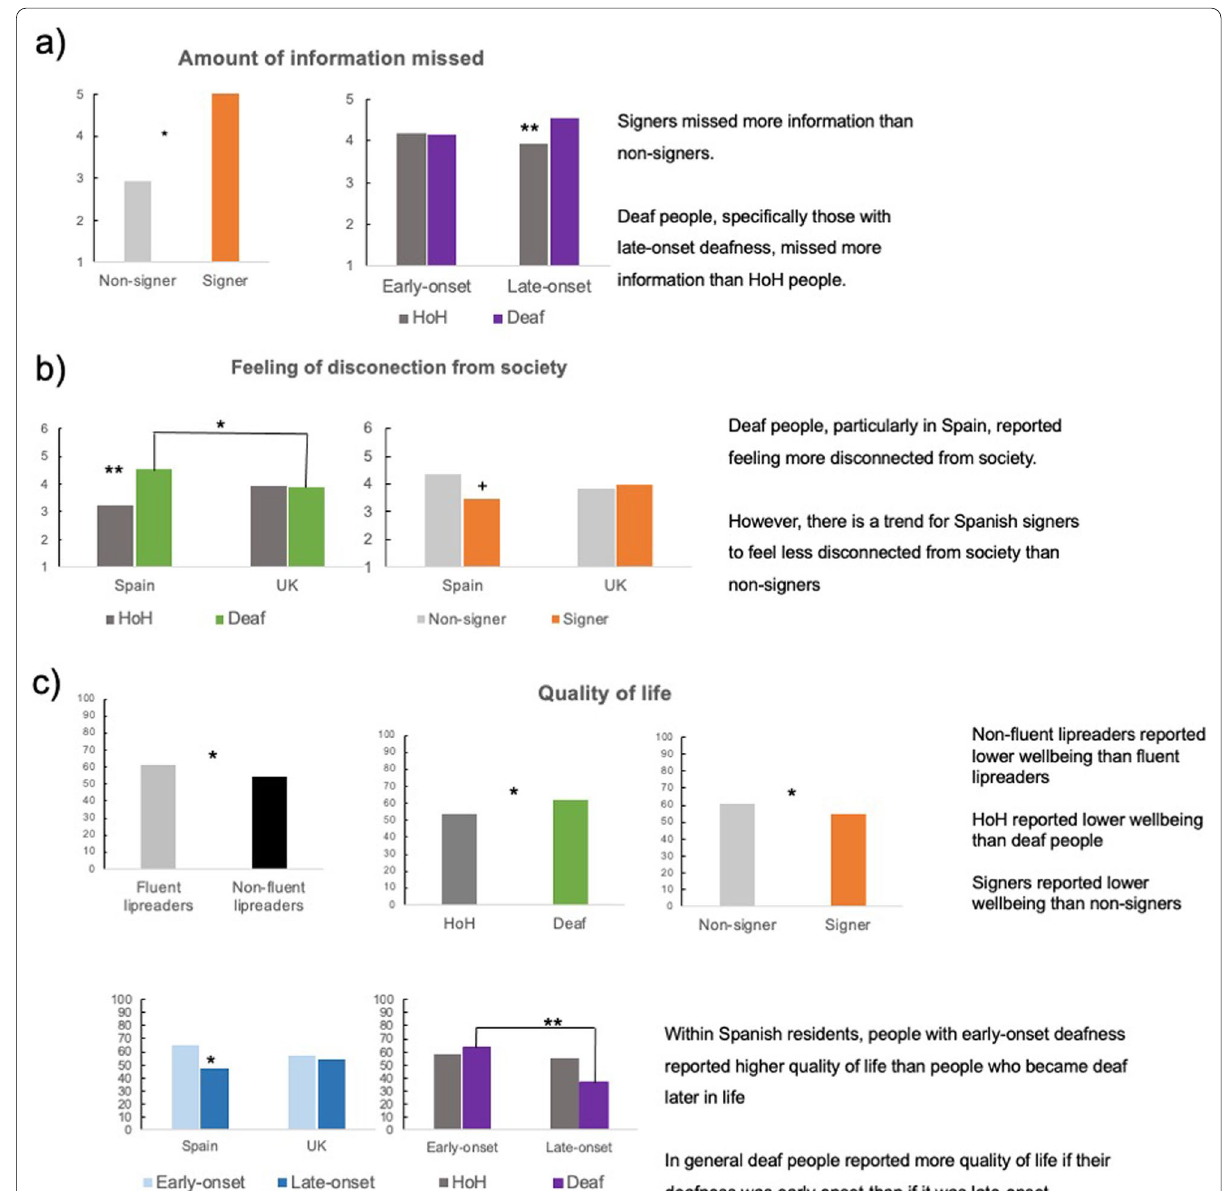
Fig. 4 Overview of significant effects for the three measures of perceived loss of information and wellbeing: amount of information missed ( a ), feeling of disconnection from society ( b ) and general wellbeing: quality of life ( c ). Effects that were significant in the simple slopes analysis are coded as follows, *** p < .001, ** p > .01, * p < .05, and p < = = = + =